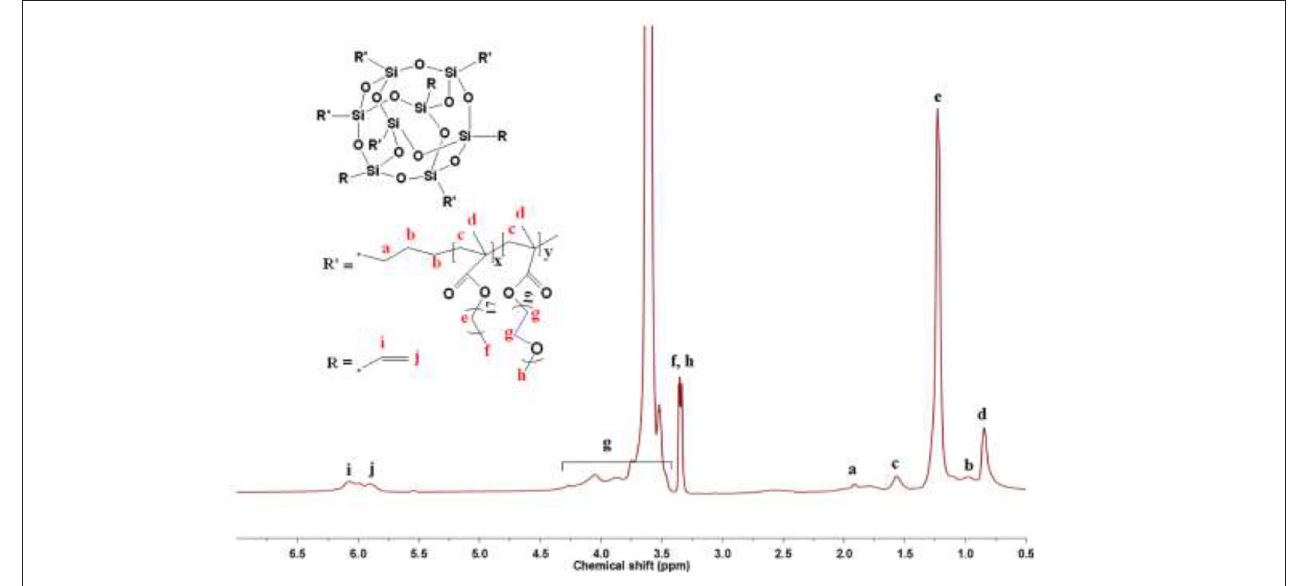
FIGURE 1 | 1 H NMR spectrum of HCP-5.